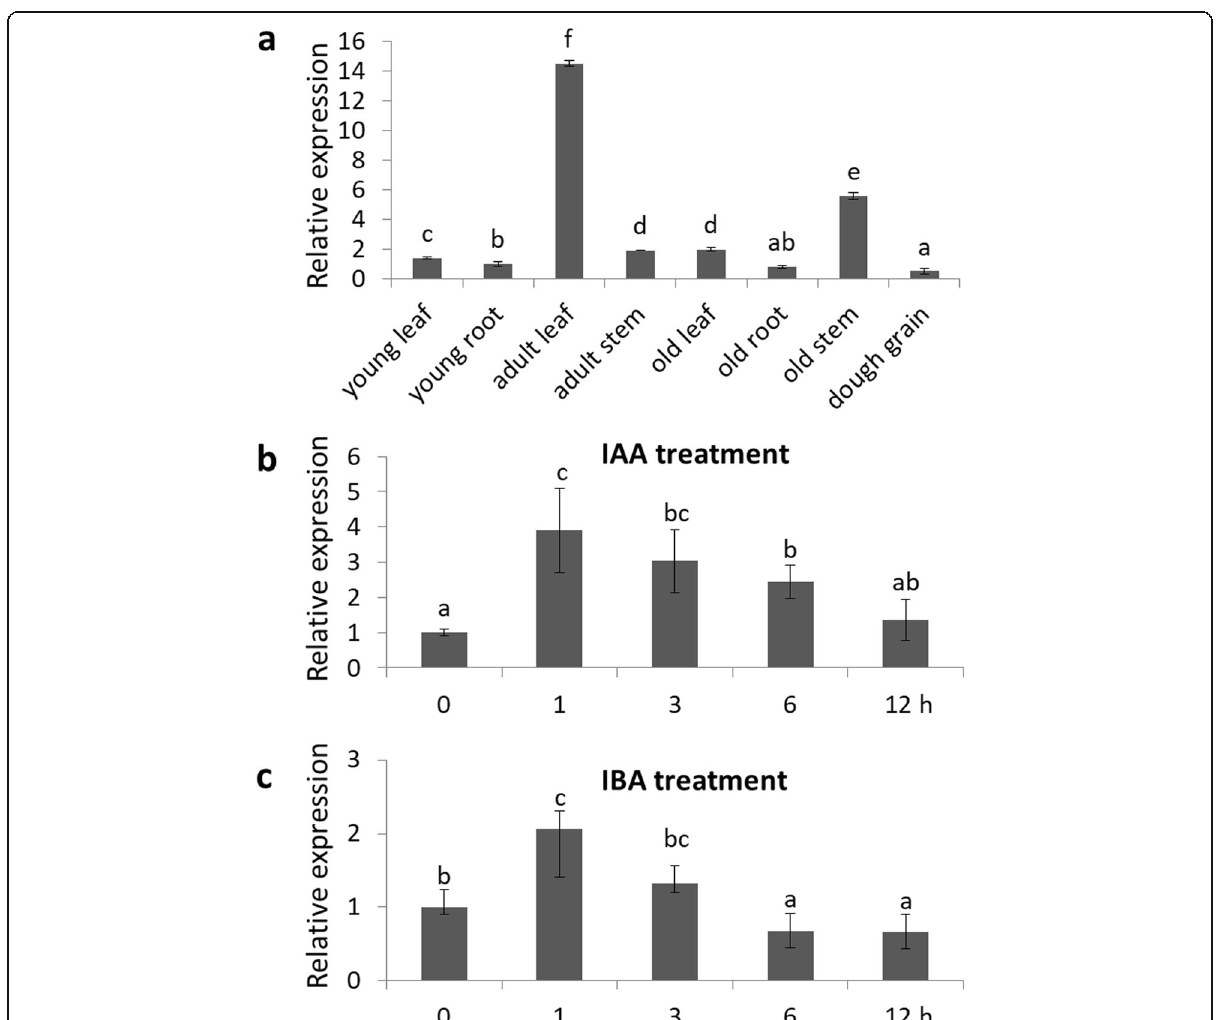
Fig. 5 The expression pattern of OsIAGT1 . a Expression pattern of OsIAGT1 in rice. Young leaf and root were harvested from two-week-old seedlings. Adult leaf and stem were from plants growing for 2 months. Old leaf, root and stem were from plants growing for three and a half months. The dough grain was from maturing seeds. Transcript levels were normalized relatively to the mRNA levels of OsActin1 . c and d Induction of OsIAGT1 transcription by IAA or IBA. One-week-old wild-type rice was subjected to treatment with or without 10 μ M IBA or 10 μ M IAA for 1, 3, 6 and 12h, respectively. Expression of OsIAGT1 was analyzed with qRT-PCR analysis. The results represent mean±SD from three replicates. Different lower-case letters indicate significant difference based on the Duncan ’ s multiple range test ( p